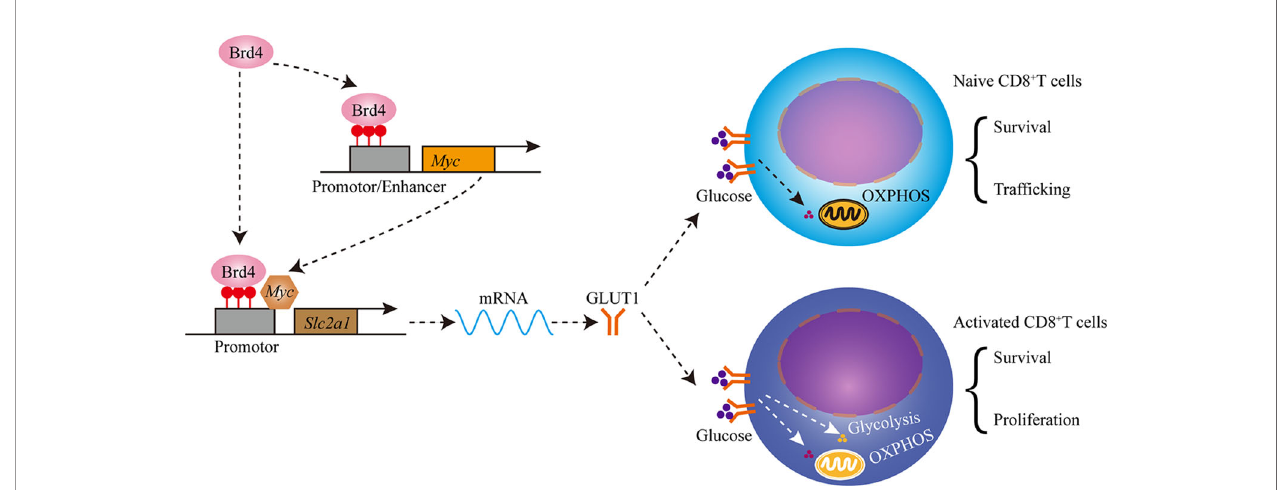
FIGURE 8 | Schematics showing that Brd4 regulates CD8 + T cell homeostasis and proliferation through controlling glucose metabolism. Brd4 maintains naïve CD8 + T cells homeostasis by regulating the survival and traf fi cking of naïve CD8 + T cells in steady-state. Brd4 promotes ef fi cient glucose uptake by upregulating GLUT1 (glucose transporter 1) and Myc expression, which glucose oxidation in mitochondria fuels naïve CD8 + T cells survival and traf fi cking. Upon activation, activated CD8 + T cells increase glucose uptake to meet the bioenergetic and biosynthetic demands, which includes quick proliferation, survival and effector